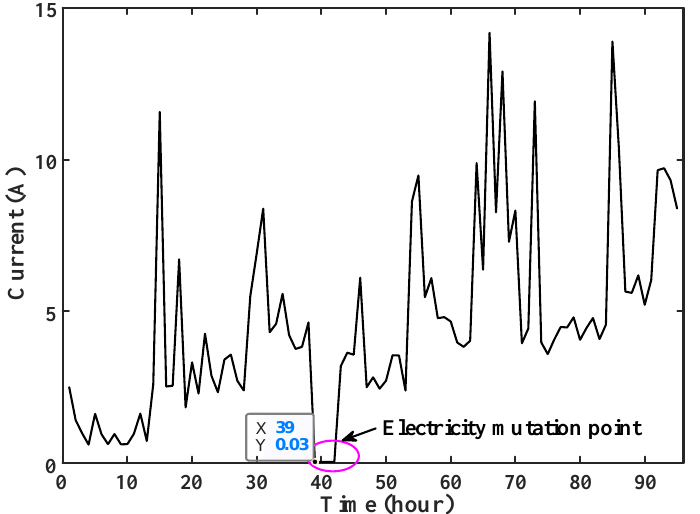
Figure 11. Abnormal electricity consumption diagram for users suspected of sudden change in load